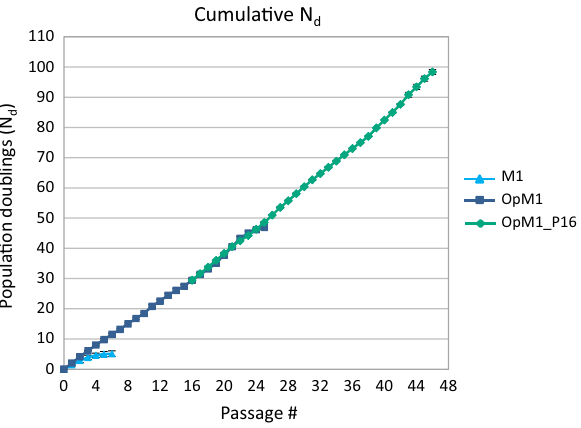
Figure 4. Cumulative population doublings (N d ) of cells from 3 individuals of G. barretti cultured in M1 and OpM1 over 5 and 25 passages, respectively. OpM1_P16 shows doublings made by cells cryopreserved after passage 16 and used to start a new culture in OpM1, which continued for at least 30 more passages (46 passages total). Error bars indicate the standard deviation from the average of biological (N = 3) and technical (n = 3)